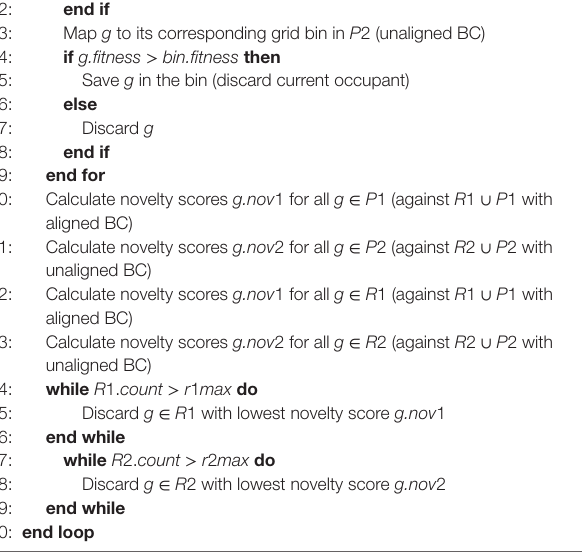
algorithm 6 | Multi-Bc MaP-elites (Me-Me) ME-ME works similarly to MENOV-MENOV, except selection is uniform rather than proportional to novelty scores (thus there is no need for novelty archives R 1 and R 2). Modifications to Algorithm